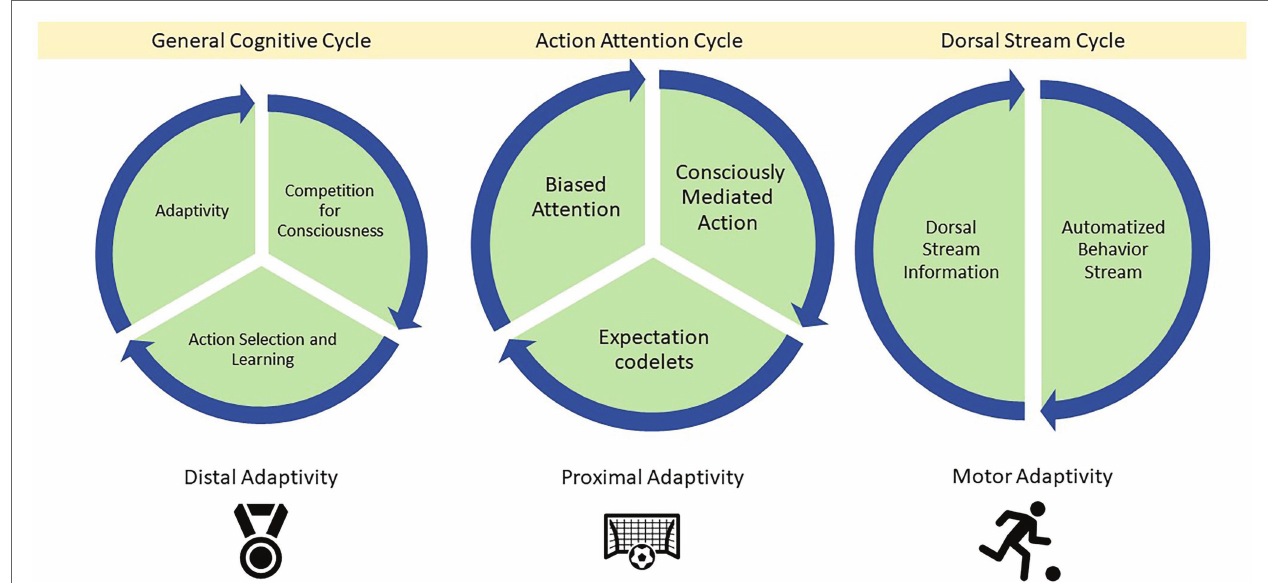
FIGURE 9 | Here, we see three feedback loops that aid the agent across different timescales of smooth coping. The cognitive cycle in general aims to keep the agent in an equilibrium with its environment across long time scales. For example, winning a tournament. The attention cycle attunes the agent to their current context and the task(s) they are currently undertaking. For example, the context and task of playing and winning a soccer match. Finally, the dorsal stream cycle aims to keep the agent optimally adapted to their current task at the motoric level across rapid time scales. For example, dribbling, tackling, avoiding other players, shooting at the